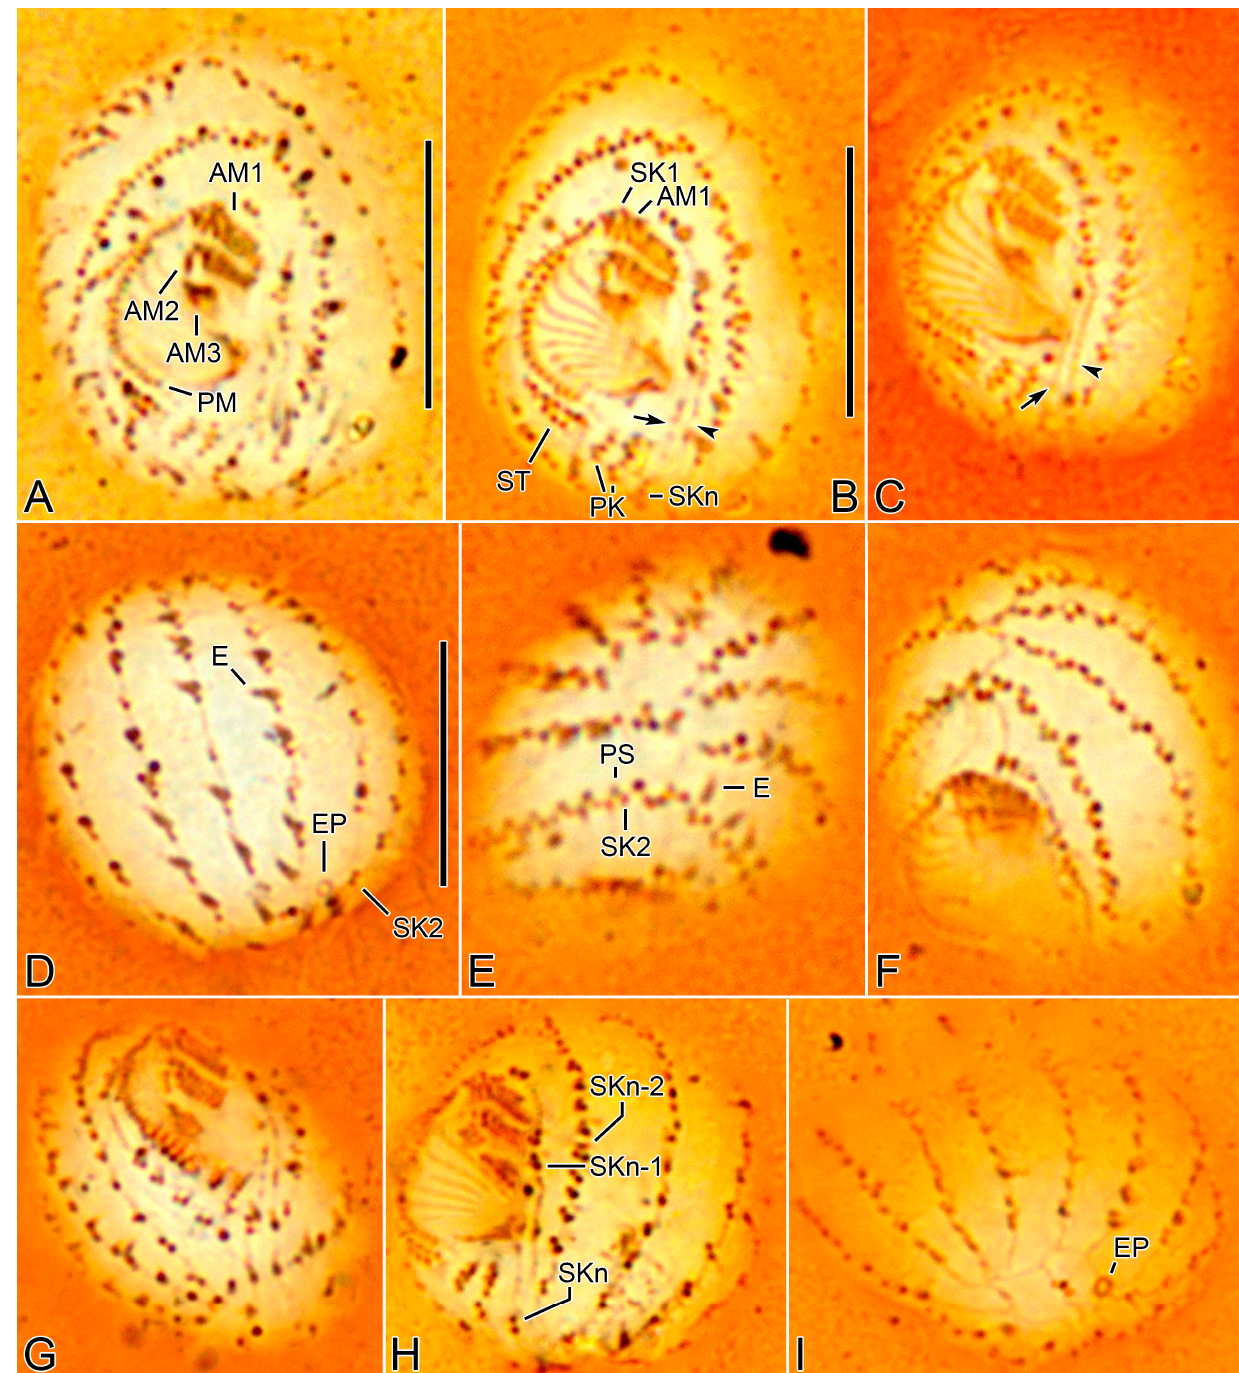
Scale bars: 10 µm.